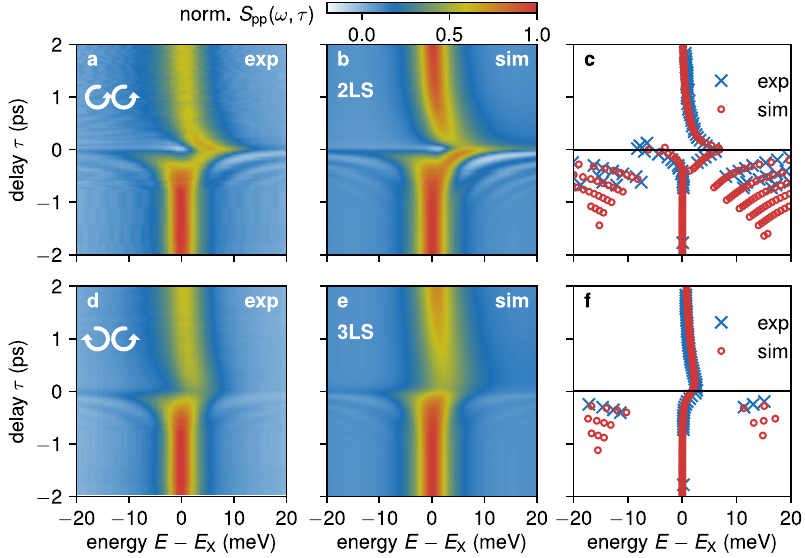
Figure 4: Delay scan of pump-probe spectra for P = 45 μ W.0 (a–c) Co-circular polariza- tion. (d–f) Cross-circular polarization. (a and d)Experiment. (bande) simulation,(b)in the 2LS and(e) in the 3LS. (c andf)Local spectral maximain theexperiment (blue crosses) and simulation (red